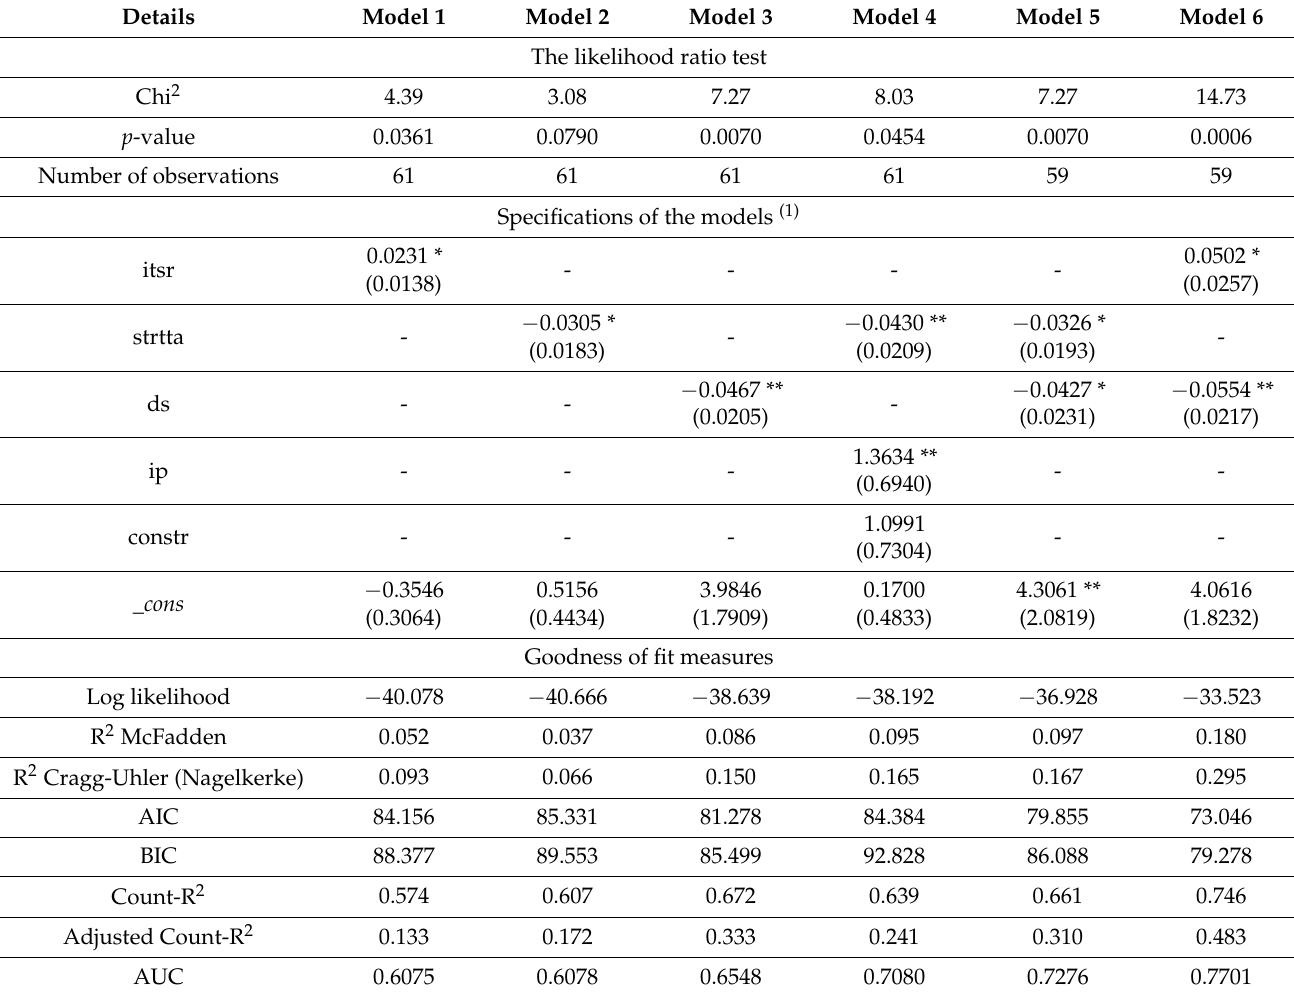
Table 4. Estimation results of logistic regression models for concluding an arrangement in restructuring